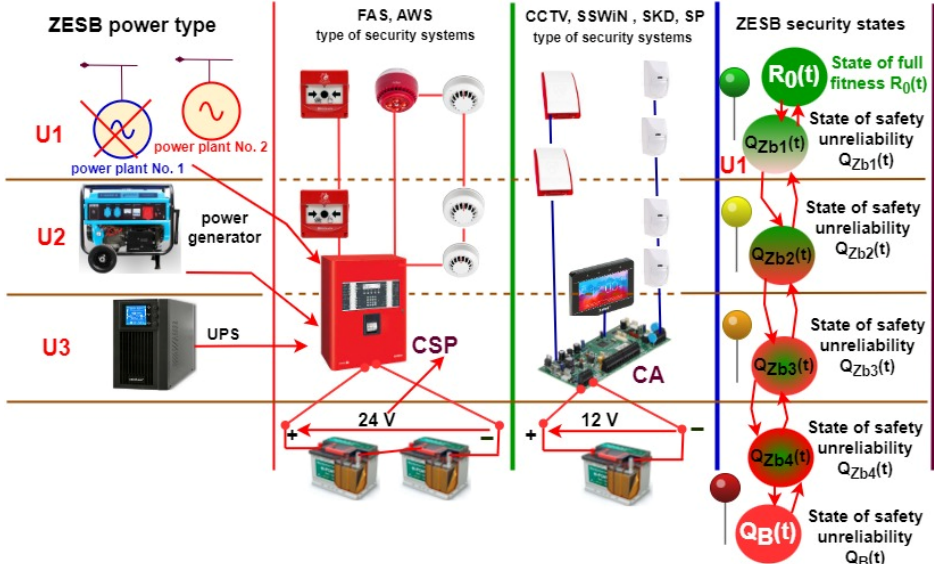
Figure 4. A solution to an IESS power supply in an SB and vast SCI areas, where: U1, 2, 3—unfitness No. 1, 2, 3, respectively; R 0 (t)—probability function related to an IESS staying in the S PZ state of full fitness; Q Zb1 (t), Q Zb2 (t), Q Zb3 (t), and Q Zb4 (t) D22 (t)—probability functions related to an IESS staying in individual safety hazard states, Q B (t)—probability function related to an IESS staying in a state of safety unreliability, and S B —damage to all power supply systems.